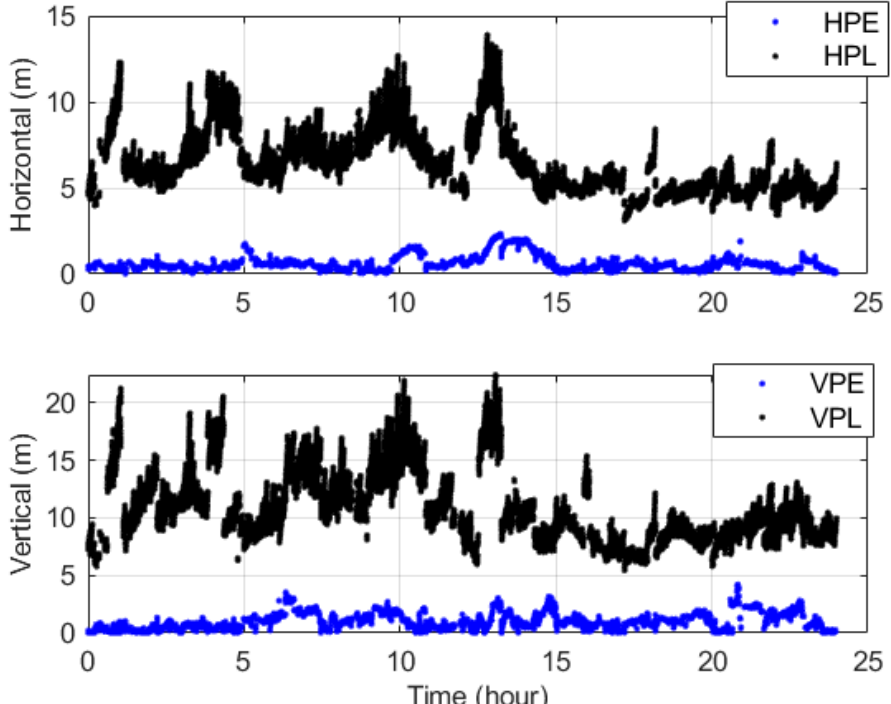
Figure 9. Time series of position errors and protection levels at the Beijing station.